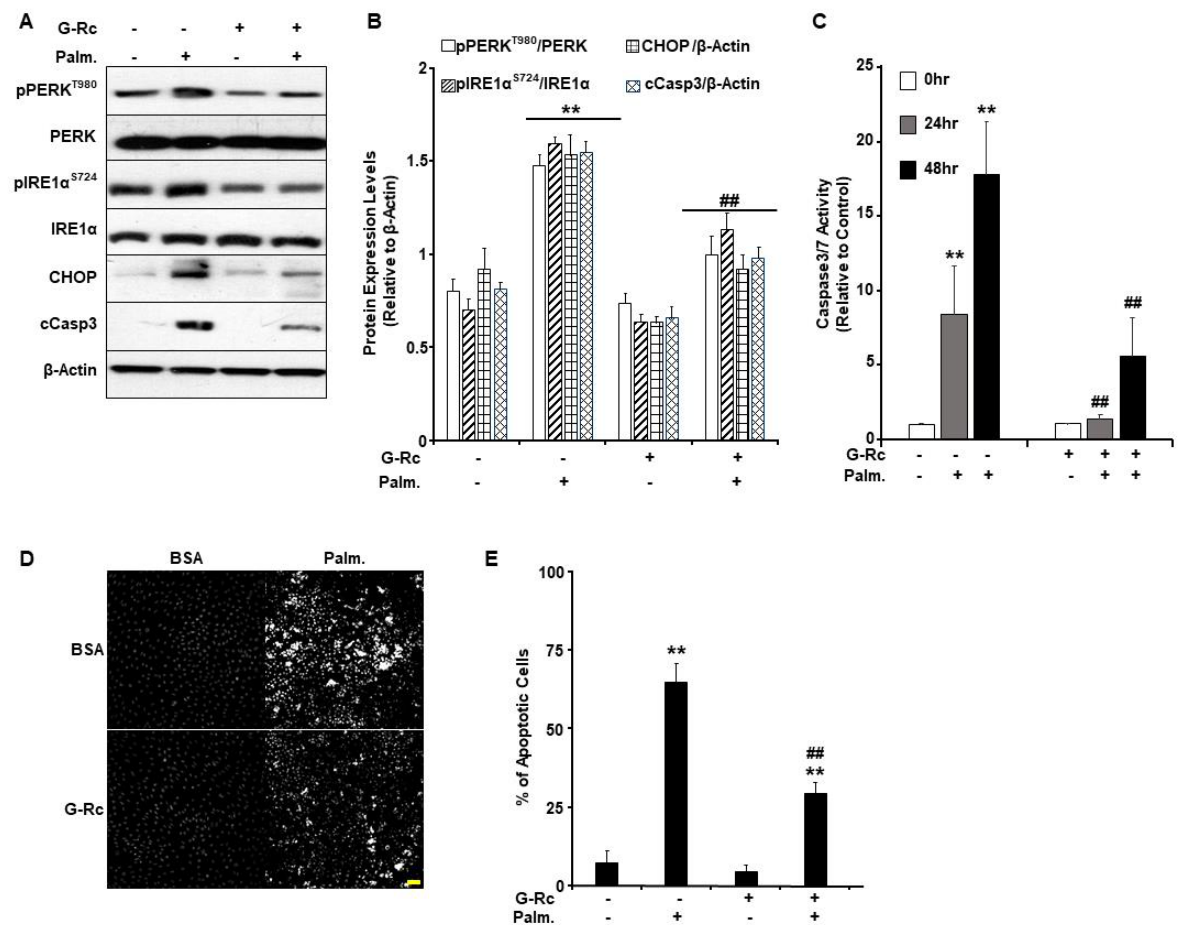
difference between palmitate/G-Rc-treated cells versus cells treated with palmitate only.